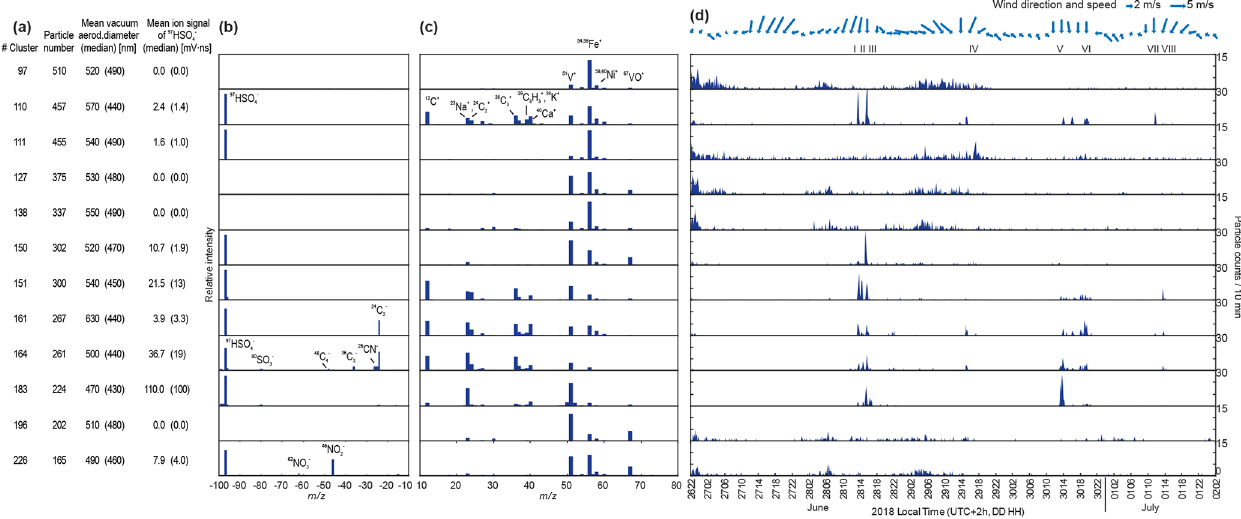
Figure 4. Results of the ART-2a clustering for 12 of the 15 clusters showing signatures of residual fuel combustion. (a) Cluster number according to their labels in the full cluster analysis (see the Supplement), particle number, vacuum aerodynamic diameter and average sulfate signal of the clusters. (b) Weight matrices (spectra of the cluster center) of negative ions and (c) positive ions corresponding to average mass spectra. (d) Top: measured wind data and ship plume numbers; bottom: time series of particle counts with 10min resolution. Note the different y -axis scales. While only mass spectral data were considered in the clustering algorithm, the time series of the resulting clusters also reveal two distinct groups: the transient group with bipolar mass spectra and short events as well as the background group with dominant metal signatures and smooth time series. Table 1. Mass spectral signatures that indicate the degree of ageing for particles from residual fuel